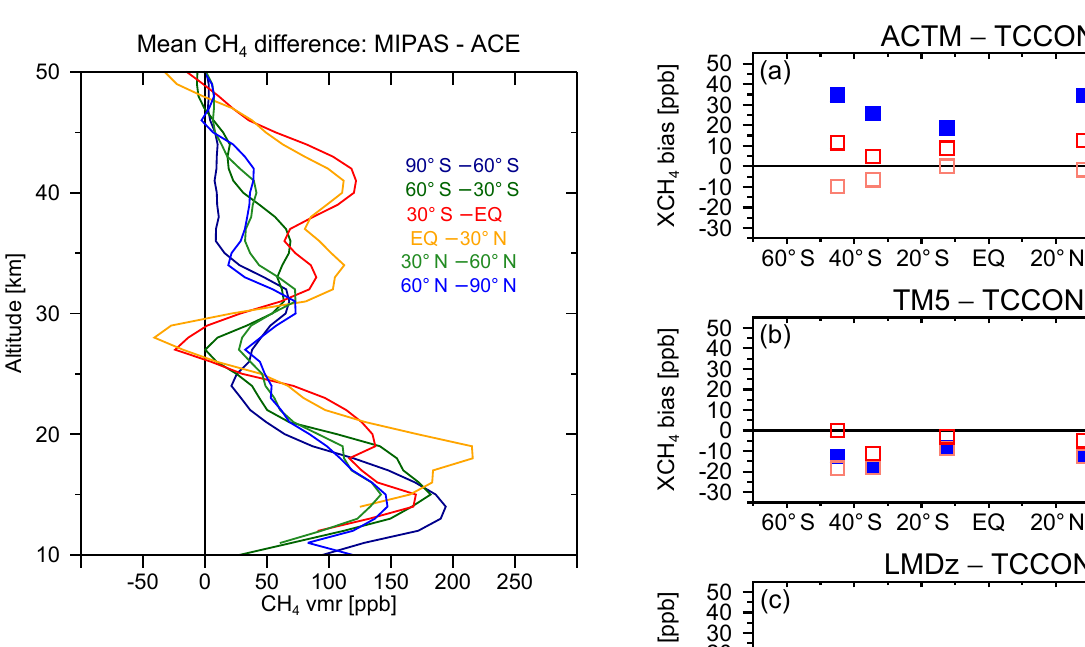
Figure 1. Mean CH 4 differences between collocated MIPAS and ACE-FTS CH 4 profiles measured in the year 2010. Mean CH 4 dif- ferences in parts per billion (ppb) are derived for 30 ◦ latitudinal bands indicated by different colors.